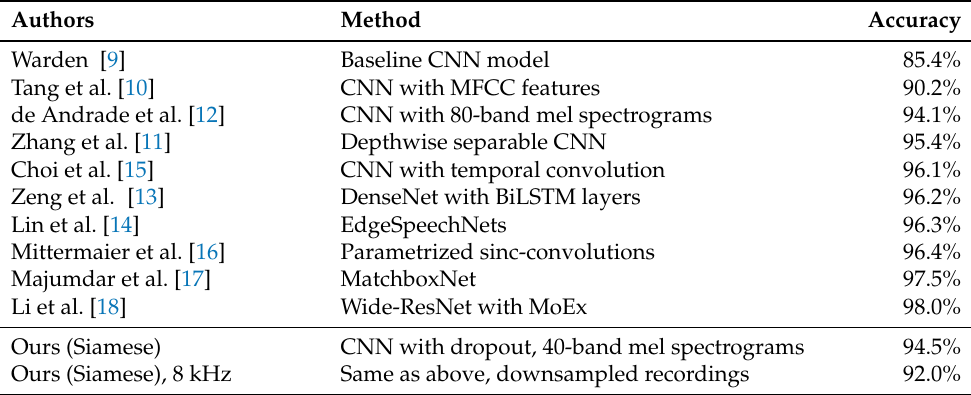
Table 3. Top-1 classification accuracy for isolated words of Speech Commands